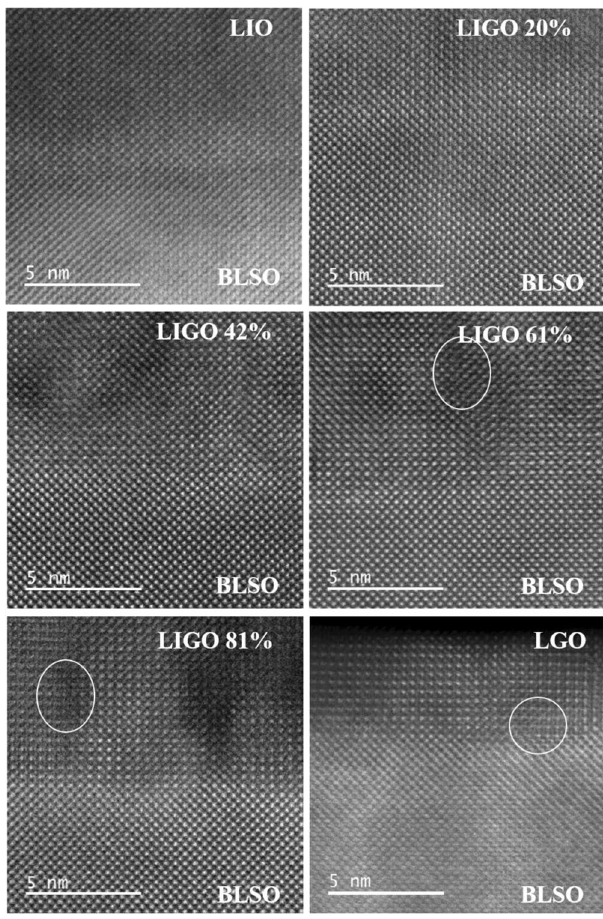
Fig. 2 Cross-sectional high-angle annular dark fi eld scanning transmission electron microscope (HAADF-STEM) images of BLSO/ LIGO interface in various Ga alloying ratios. Coherent epitaxial growth is con fi rmed when the Ga alloying ratio is 0, 20, and 42%, but dislocations are observed when the alloying ratio is 61, 81, and 100%. The white circles represent dislocations where extra (110) pc layers start to appear. It is easier to observe the dislocations in the [110] pc direction. The growth direction is [001] pc and the lateral direction is [100] pc